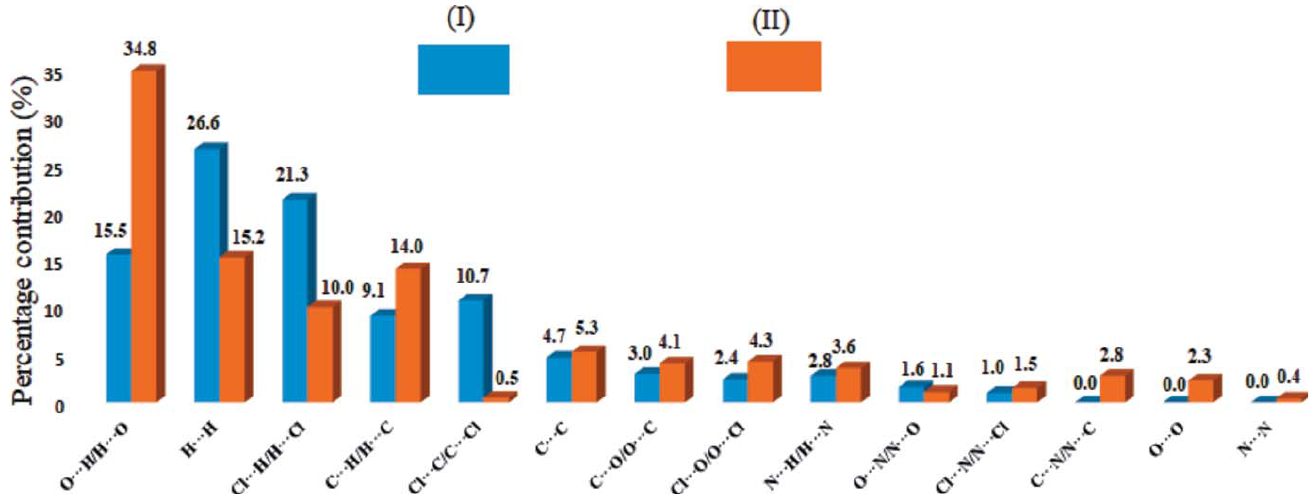
Figure 8 Quantitative results of different intermolecular interactions contributing to the Hirshfield surfaces of (I) and